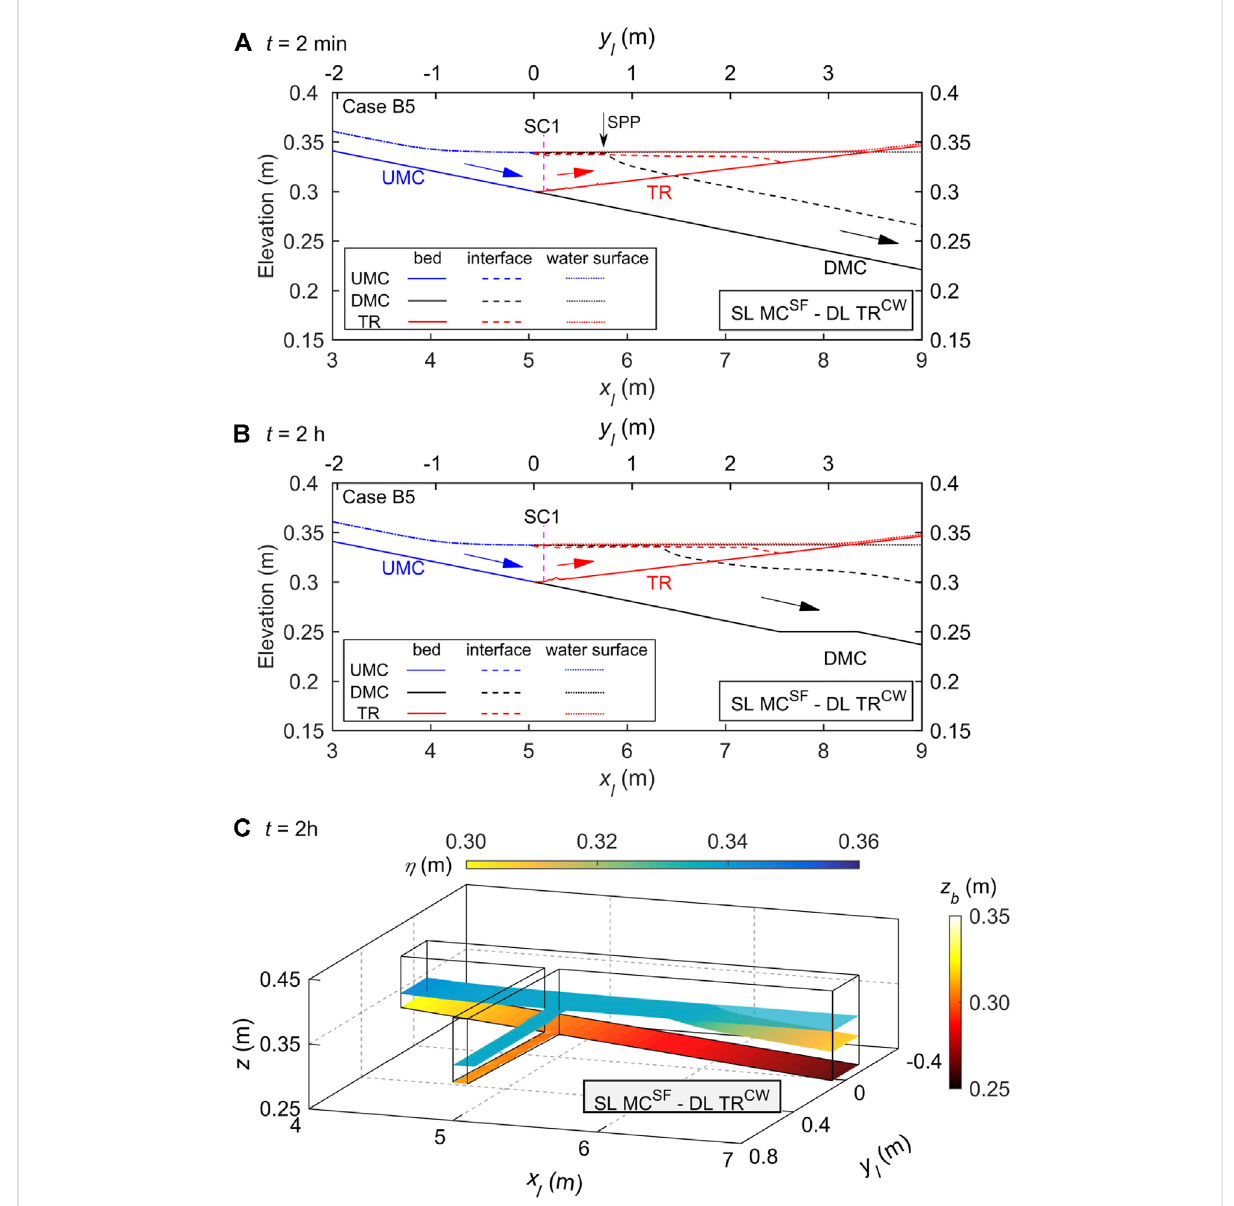
Case B5 of SL MC SF — DL TR CW for high-concentration sediment-laden fl ow in the main channel (MC)and low discharge clear-water fl ow in the tributary (TR), where UMC and DMC denote upstream and downstream of the MC con fl uence, and SPP is stable plunge point: free water surface elevation,interface,andbedelevationpro fi lesalongthecentralaxesofthemainchannelandtributaryat (A) astablestate( t =2 min), (B) along-term state ( t = 2 h); and (C) three-dimensional layered fl ow structure at t = 2